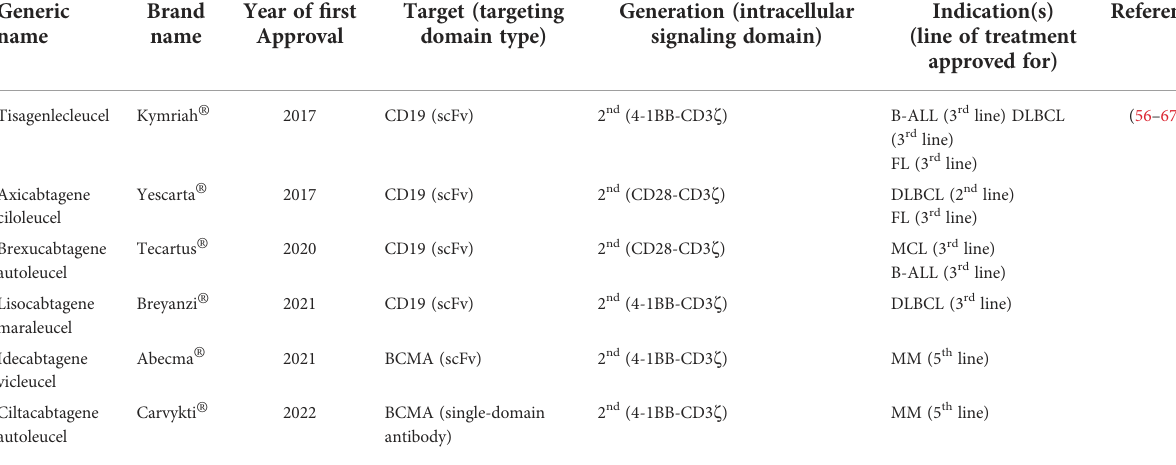
TABLE 1 A list of CAR-T products approved by the US FDA for the treatment of different hematologic